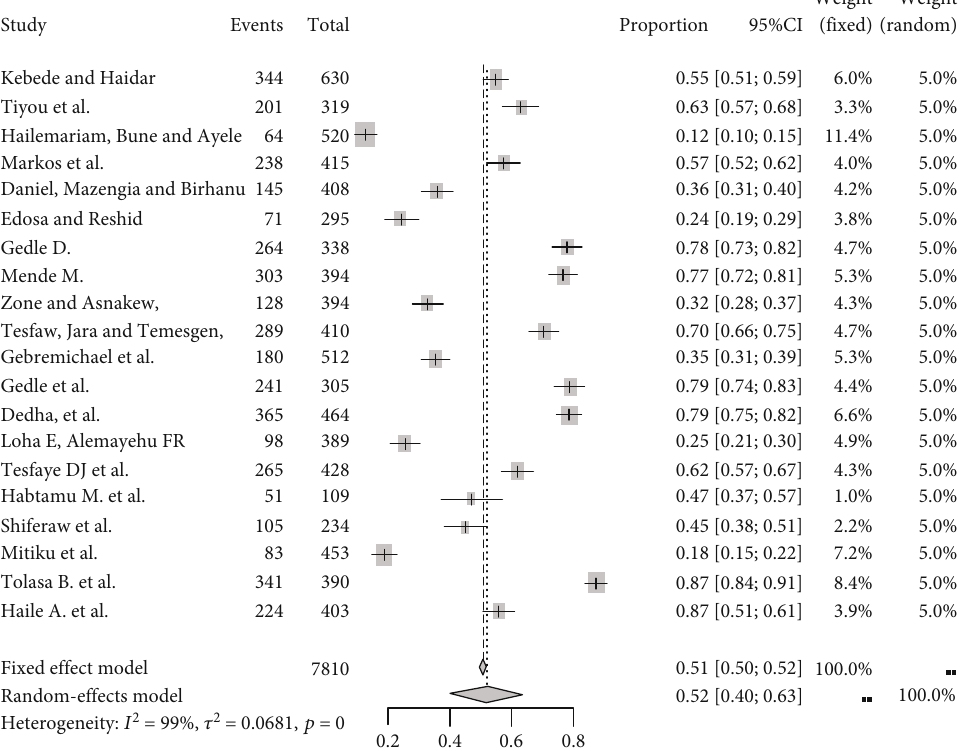
Figure 2: Forest plot showing the pooled prevalence of food insecurity among adult people with HIV in Ethiopia from 2012 up to